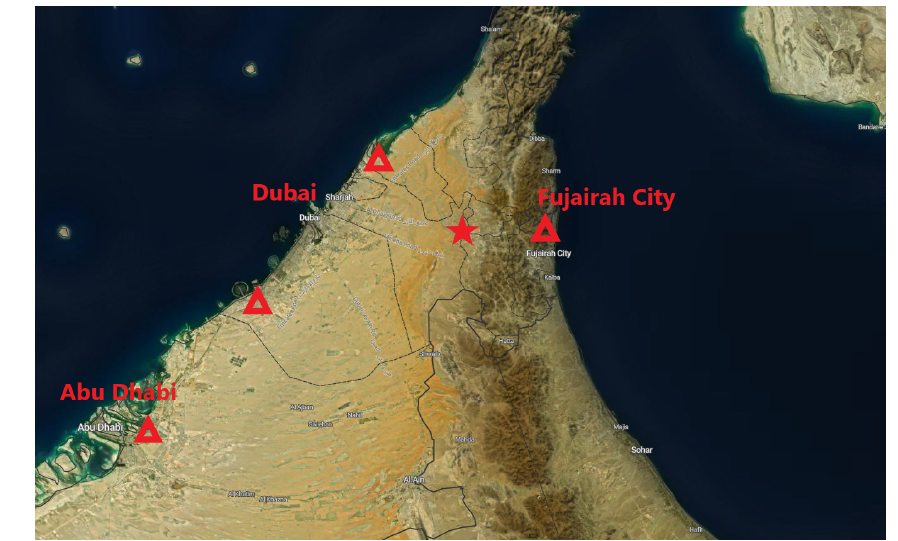
Figure 1. A map (Buchhorn et al., 2020) showing the location of the measurement site with a red star. The red triangles represent the locations of significant oil refineries known by the writers. © Copernicus Service Information